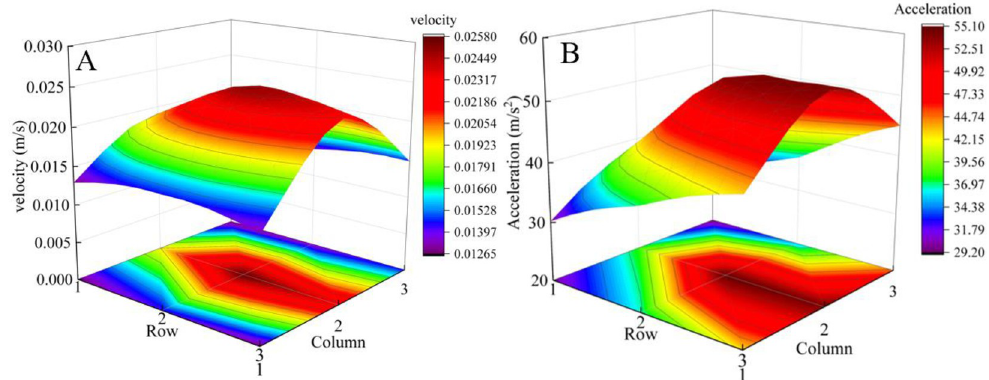
Fig 10. Strength distribution of vibration signals on tail beam. (A) The strength distribution of velocity signals. (B) The strength distribution of acceleration signals.